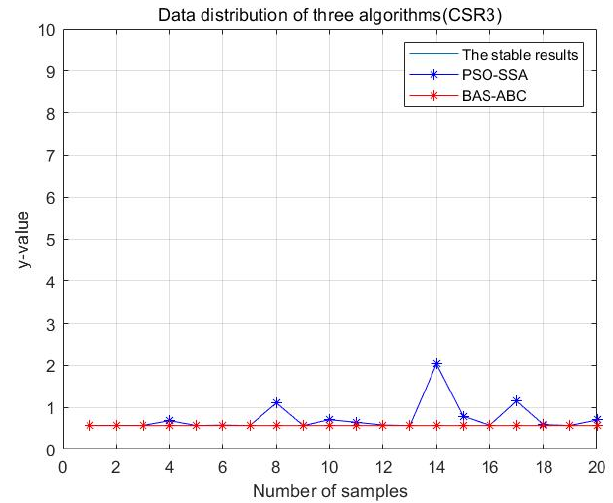
Figure 31. Data distribution—20 of two hybrid algorithms (CSR2).